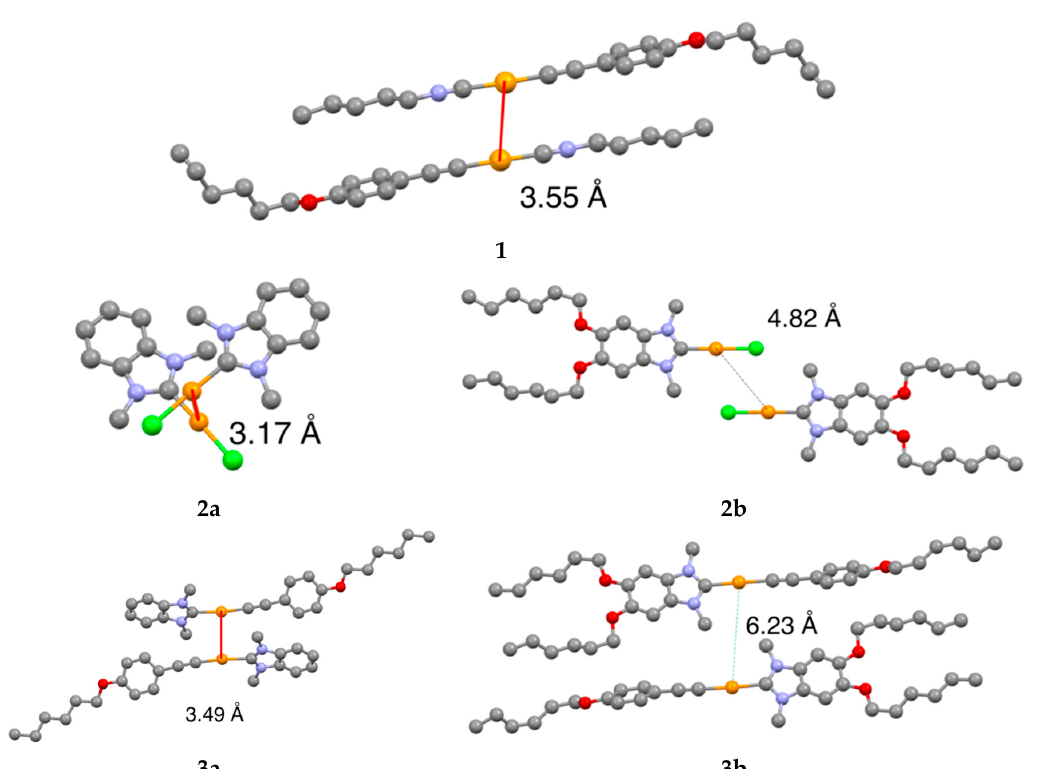
Figure 2. Crystal structure of gold complexes. Color legend: gray, C; red, O; purple, N; green, Cl; orange, Au. Intermolecular Au–Au interactions are indicated with a red line.